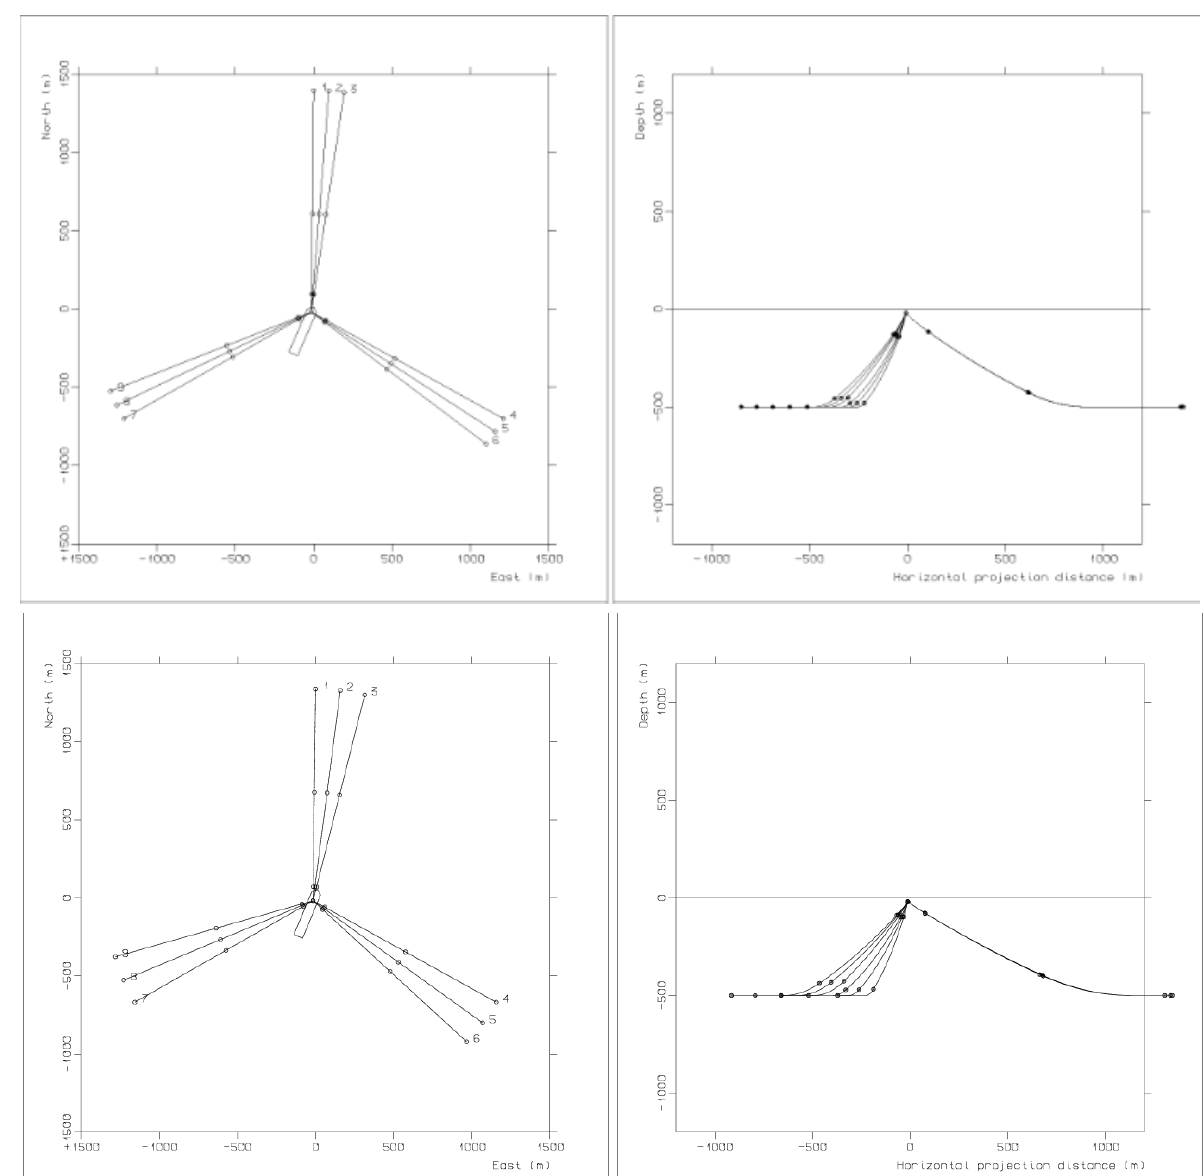
Figure 5. Initial ( top ) and optimized ( bottom ) mooring configurations for Case A.